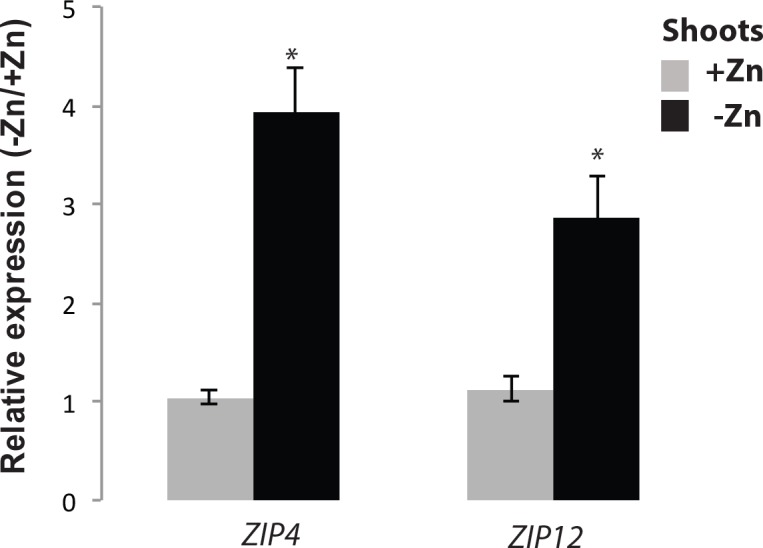
mRNA abundance of Zn-responsive genes ZIP4 and ZIP12 in roots of Col-0 plants grown in presence and absence of Zn.Reverse transcriptase qPCR analyses of transcript level changes in response to Zn-deficiency of the genes ZIP4 (At1g10970) and ZIP12 (At5g62160) in shoots of Arabidopsis (Col-0). Seedlings were grown on vertical agar plate in presence or absence of Zn for 18 days. Transcript levels of these genes are expressed relative to the average transcript abundance of the UBIQUITIN10 (UBQ10; At4g05320) that was used as an internal control. Every data point was obtained from the analysis of shoots collected from a pool of six plants. Data presented are means of three biological replicates ±SE. Asterisks indicate statistically significant differences compared to the +Zn condition for each gene analyzed (p<0.05).